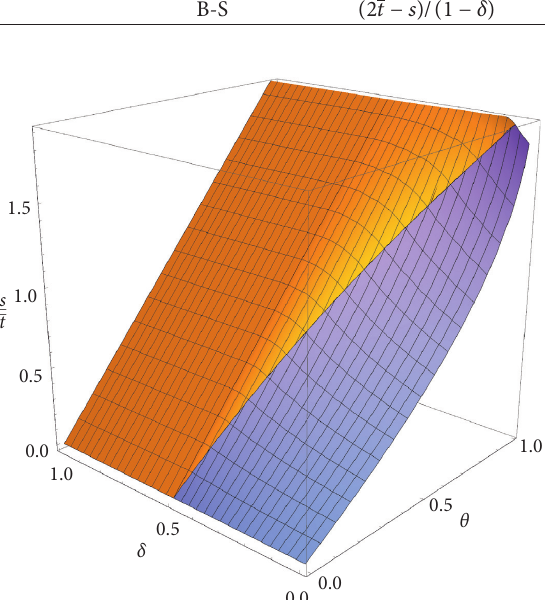
Figure 4: The threshold value of CCR above which the retailer should offer BOPS.